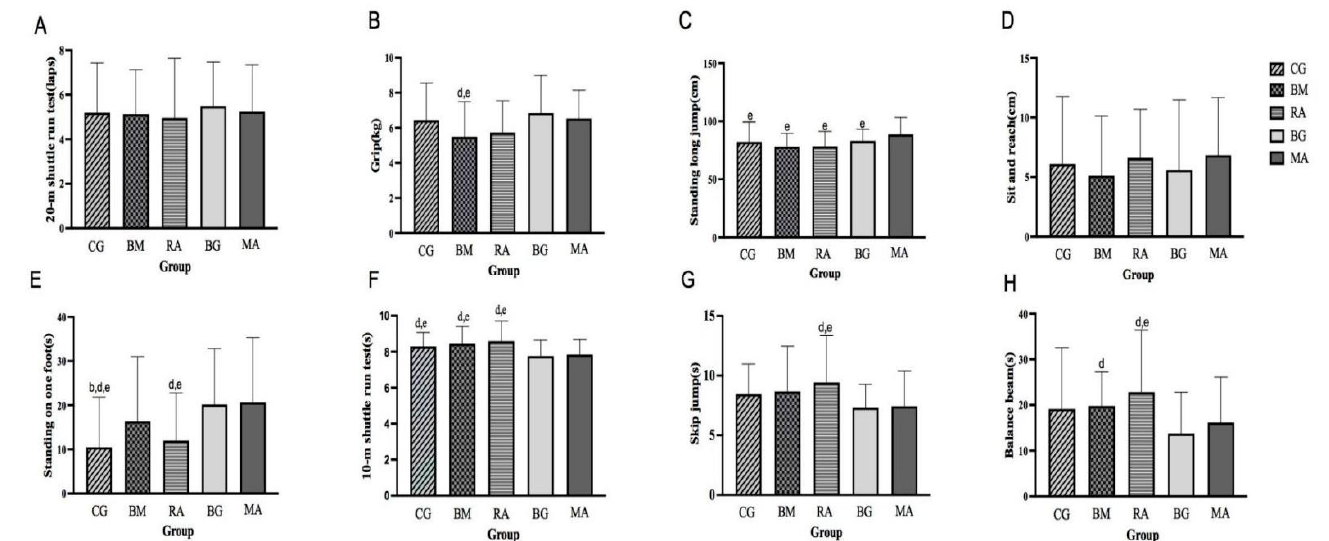
Figure 2. The results of the generalized linear mixed-model analyses for physical fitness tests after intervention. CG, Control group; BM, Basic movements group; RA, Rhythm activities group; BG, Ball games group; MA, Multiple activities group. The 20 m shuttle run test ( A ), Grip ( B ), Standing long jump ( C ), Sit-and-reach ( D ), Standing on one foot ( E ), 10 m shuttle run test ( F ), Skip jump ( G ), Balance beam ( H ) in CG, BM, RA, BG, and MA groups. b: CG vs. BM p < 0.05, d: CG, BM, RA vs. BG p < 0.05, e: CG, BM, RA, BG vs. MA p < 0.05, adjusted for age, sex, BMI, height, weight, and physical fitness test in the pre-experiment stage under each condition.